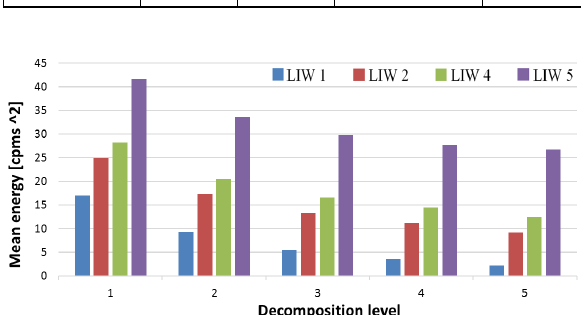
Fig. 9. Comparison of energy of approximations for different levels of decomposition (db2